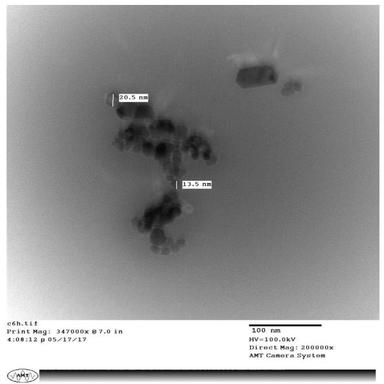
TEM image of Ch-PANI-NiO nanocomposite.